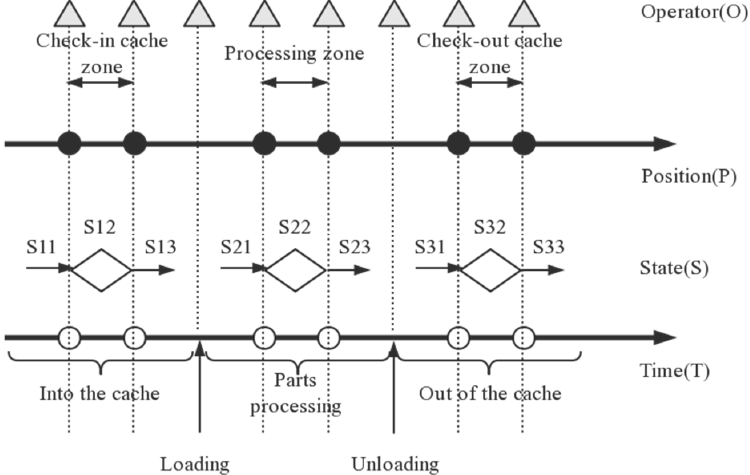
Figure 5. RFID (Radio Frequency Identification Devices) tracking configuration model based on production process.